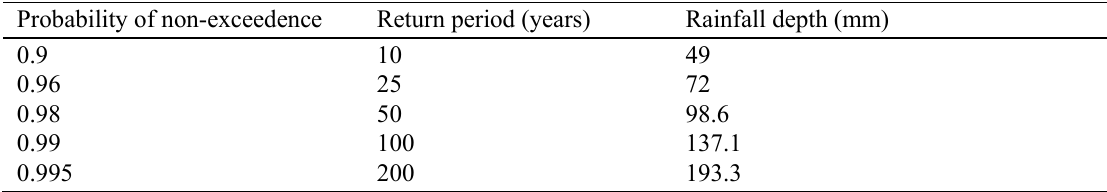
Table 3 Rainfall depths at different return periods using GEV